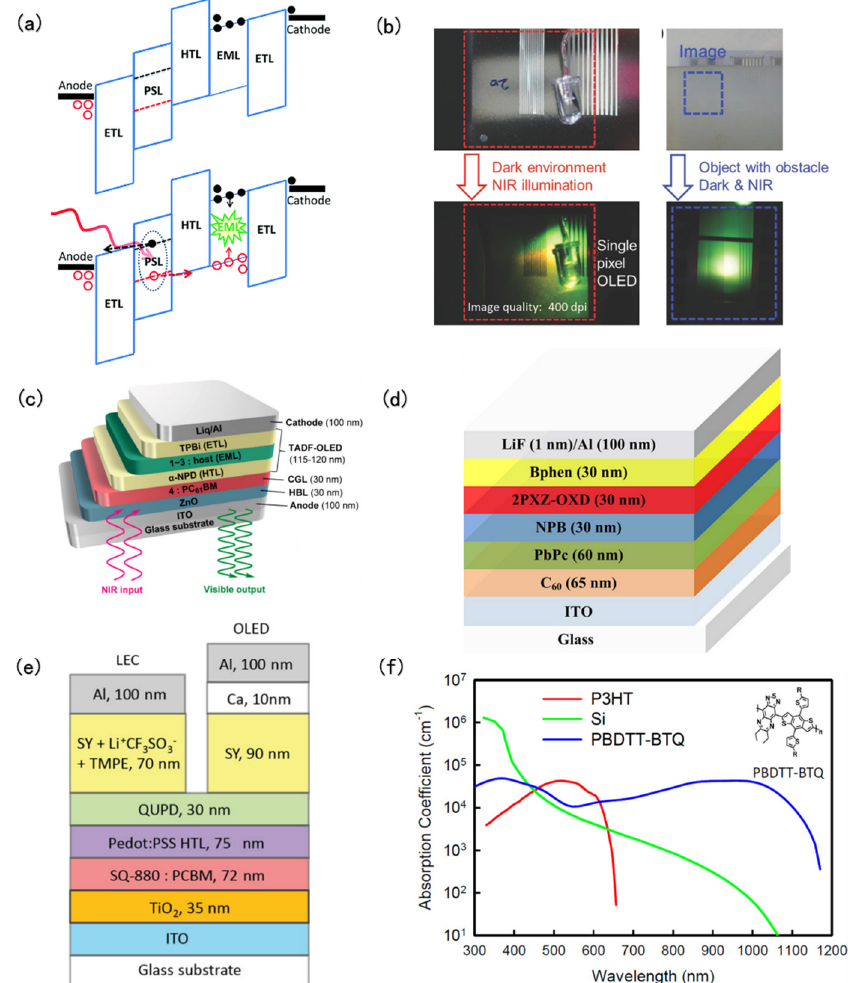
Figure 3. Structures and performance characterization of all-organic NIR-to-visible upconversion devices. ( a ) Structure and working mechanism of the upconversion device under dark (top image) and illumination condition (lower image) [35]. Copyright 2018, Materials Horizons. ( b ) Picture of the line-shadow mask and LED in night vision (left picture), and the picture of the line-shaped shadow mask when an obstacle (waste-water-filled cloudy box) was placed between the mask and the camera (right picture) [36]. Copyright 2015, Advanced Material. ( c ) Structure of the upconversion devices based on TADF-OLEDs [37]. Copyright 2017, ACS Photonics. ( d ) Structure of the upconversion device [38]. Copyright 2018, The Journal of Physical Chemistry Letters. ( e ) Structure of the upconversion device that stacks with a LEC or an OLED as visible light-emitting component [39]. Copyright 2019, ACS Applied Materials & Interfaces. ( f ) Comparison of absorption coefficients of Si, P3HT (film), and PBDTT-BTQ (film). Inset shows the molecular structure of PBDTT-BTQ [40]. Copyright 2019, ACS Photonics.